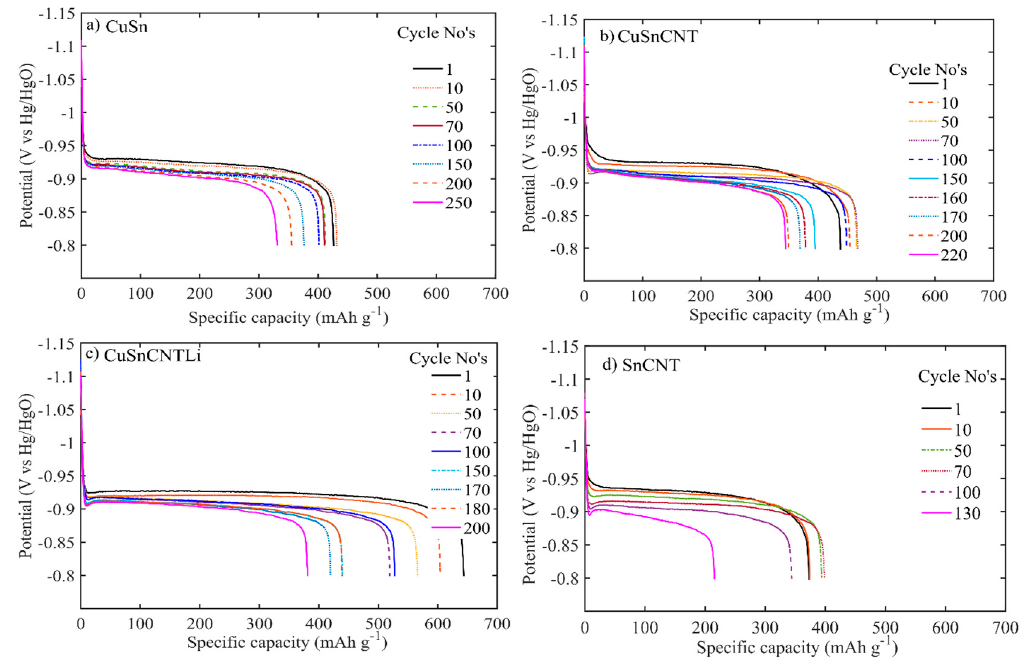
Figure 5. Specific discharge profiles of electrodes at current density of 100 mA g − 1 . Batteries 2018 , 4 , x FOR PEER REVIEW